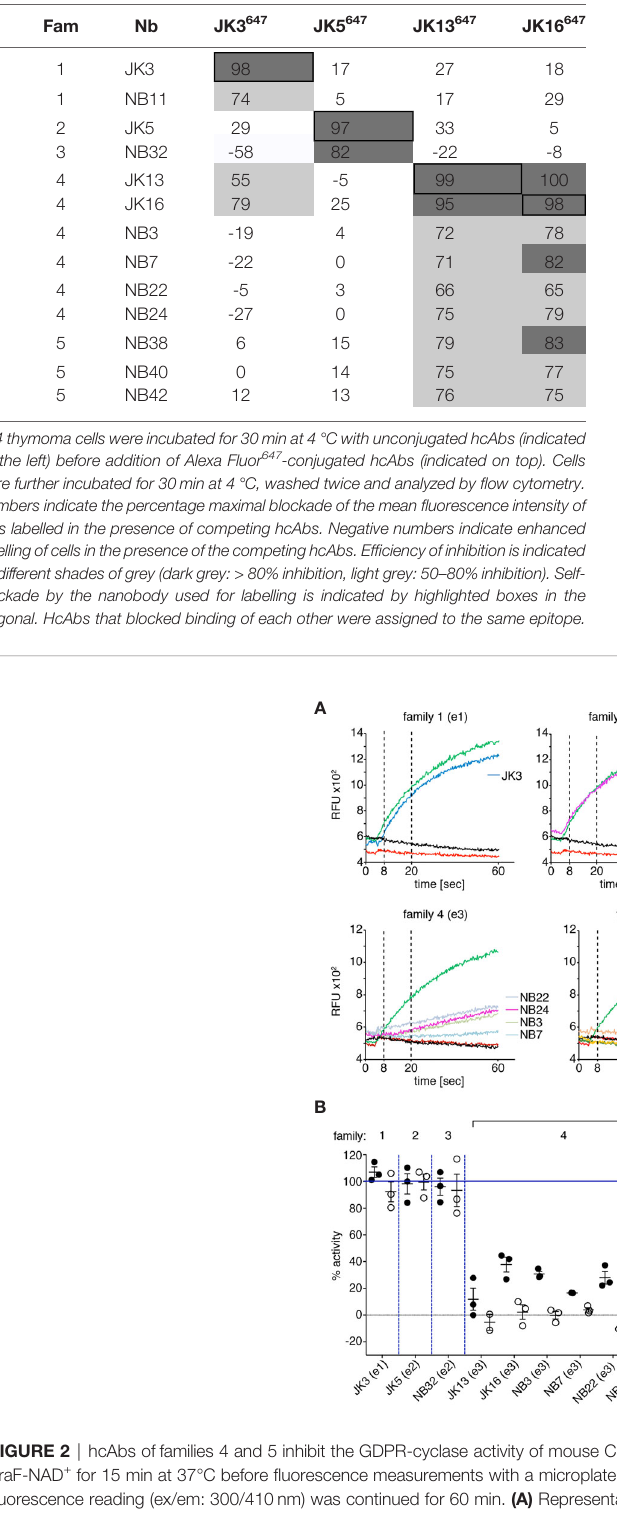
TABLE 2 | Epitope mapping of nanobody-based mouse CD38-speci fi c